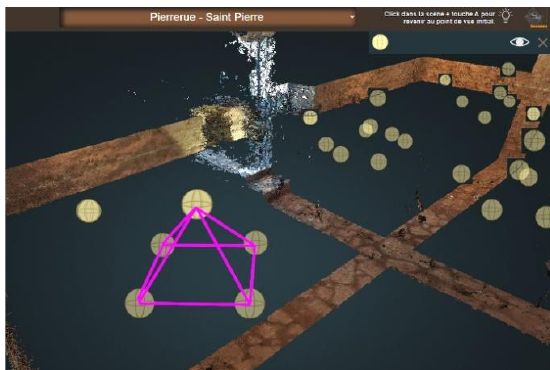
Figure 6 : Example of naming of DXF points in progress, here point ec is being edited